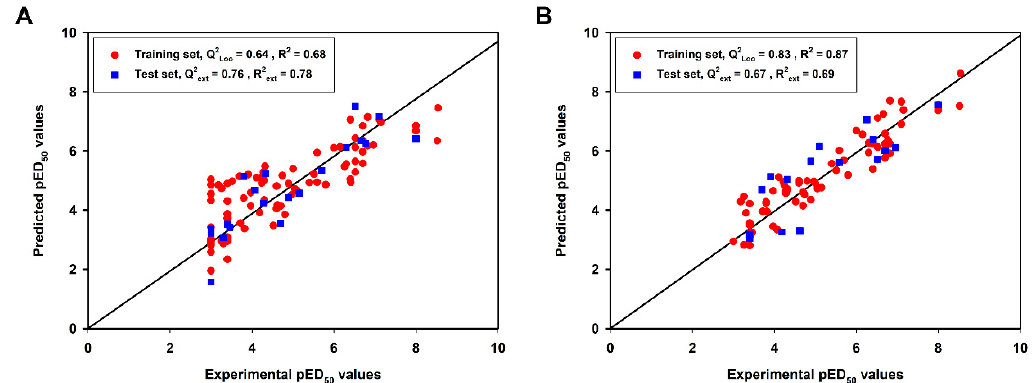
Figure 2. Plots of the experimental versus predicted pED 50 values for compounds in the training set and test set of the best models derived from initial ( A ) and further ( B ) quantitative structure activity relationship (QSAR)